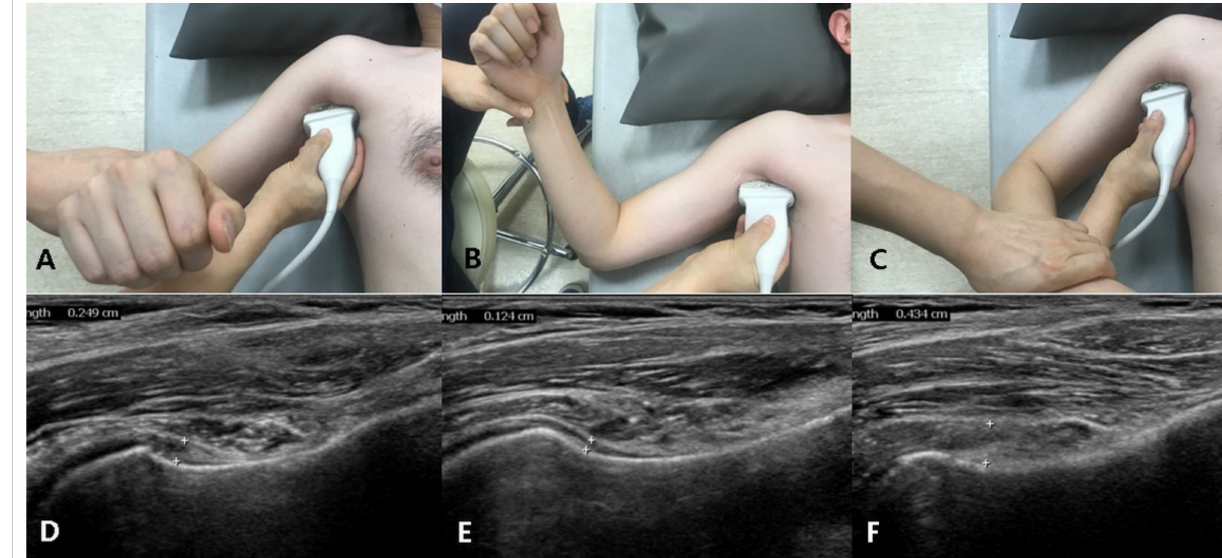
Figure 1. Arm positions and ultrasonography (US) measurement of inferior joint capsule (IJC) thickness. ( A ) Neutral position. ( B ) Externally rotated position. ( C ) Internally rotated position. ( D – F ) US measurement of IJC thickness according to arm position.